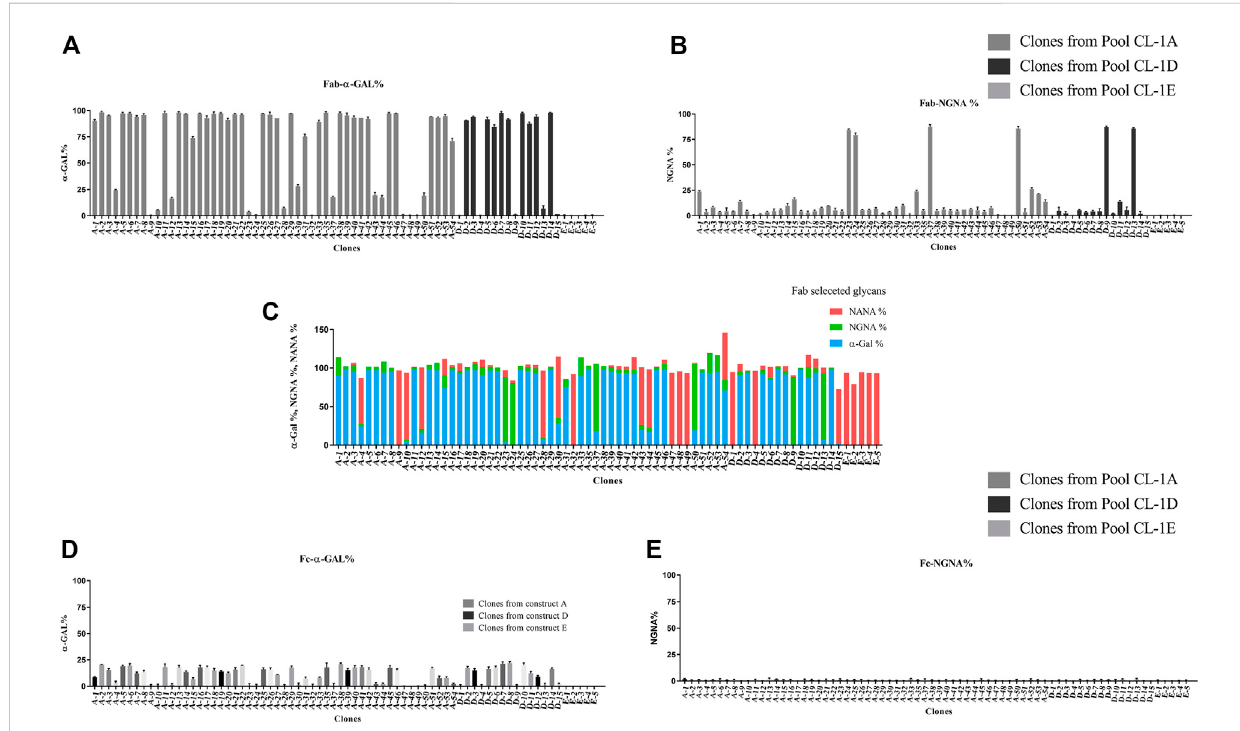
FIGURE 4 LC-MS/MS analysis was performed for glycan analysis on day 10 of fed-batch harvest samples. (A) Fab- α -Gal and (B) Fab-NGNA was observed in clones overexpressing the two genes of interest compared to the controls. (C) Inverse relation between Fab % α -Gal-NGNA-NANA was observed. (D) Comparedtothecontrol(Eclones),anincreasedlevelofFc- α -Galwasobservedinvariousclonesoverexpressingthetwogenesofinterest. (E) Therewas anegligible presence ofFc-NGNAfor all theclones. Eachdata represents culturesamples runinduplicate;error barsrepresent standard